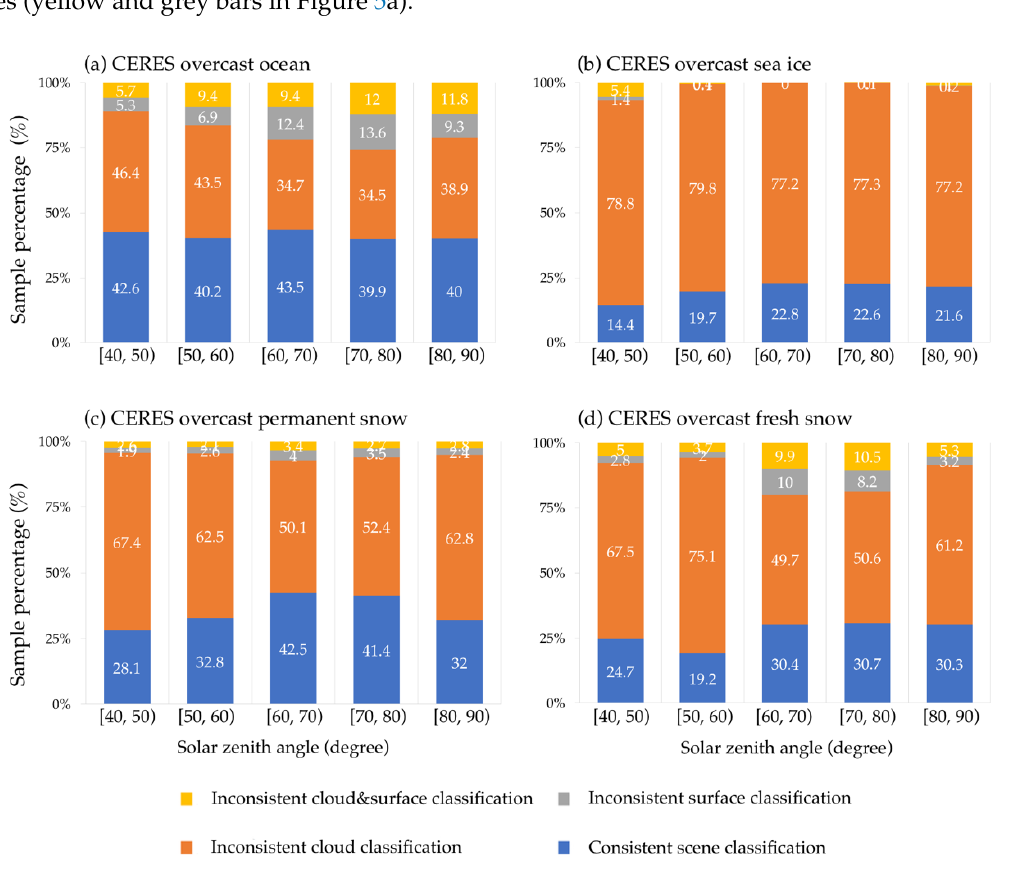
Figure 5. Stacked sample percentage (%) of MISR scene identifications for ( a ) CERES overcast ocean, ( b ) overcast sea ice, ( c ) overcast permanent snow, and ( d ) overcast fresh snow based on all three-year collocated data. Table 6. Surface classification inconsistency (%) between CERES and MISR over nadir CERES samples in 4-month (June, July, August, September) in 2007.